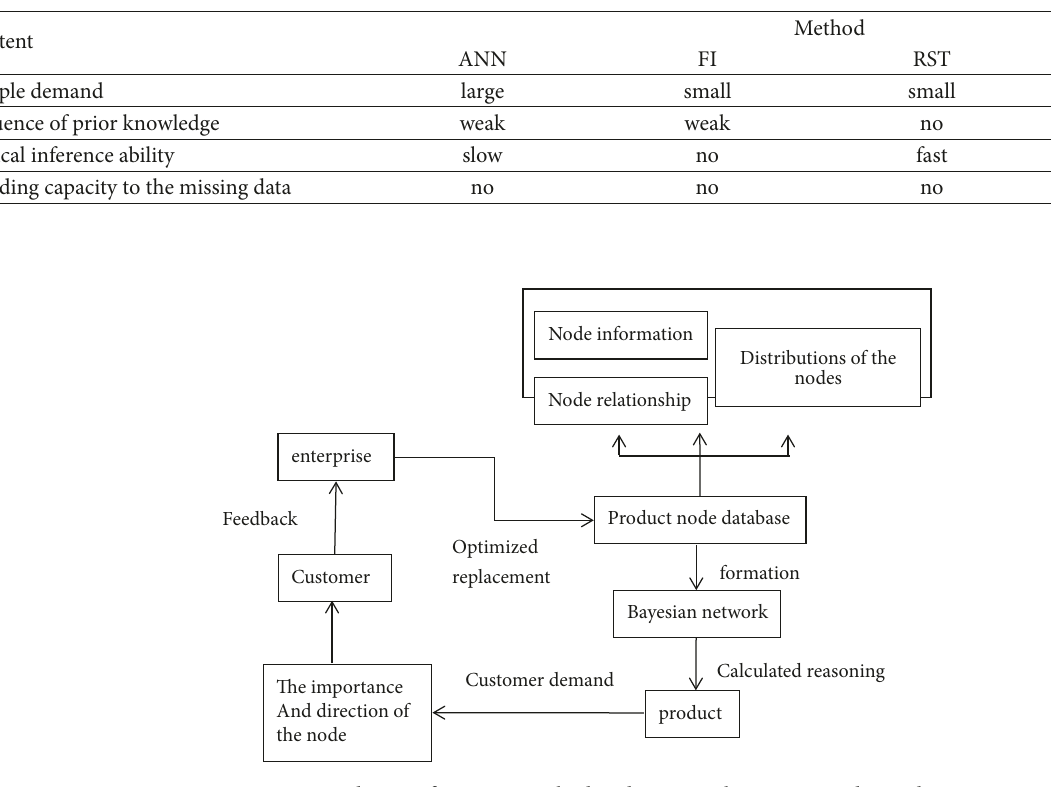
Figure 1: Product configuration method under incomplete customer